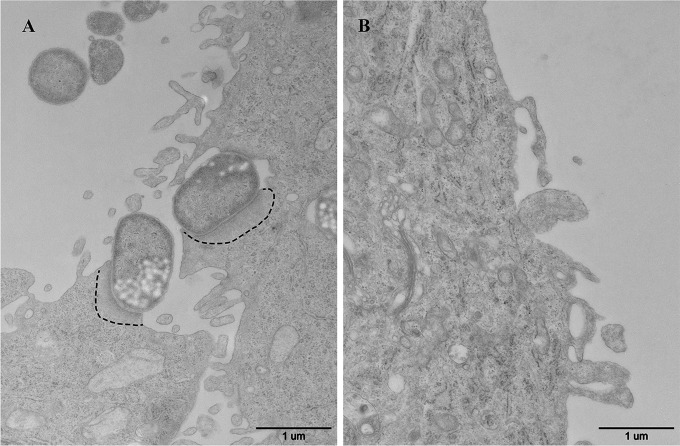
TEM image showing Escherichia coli O157:H7 adhering to HeLa cells. (A) HeLa cells adhered by the exponential-phase cells. Dashed lines indicate dense concentrations of microfilaments composed of F-actin. (B) HeLa cells adhered by the VBNC cells. Magnification, ×30,000.